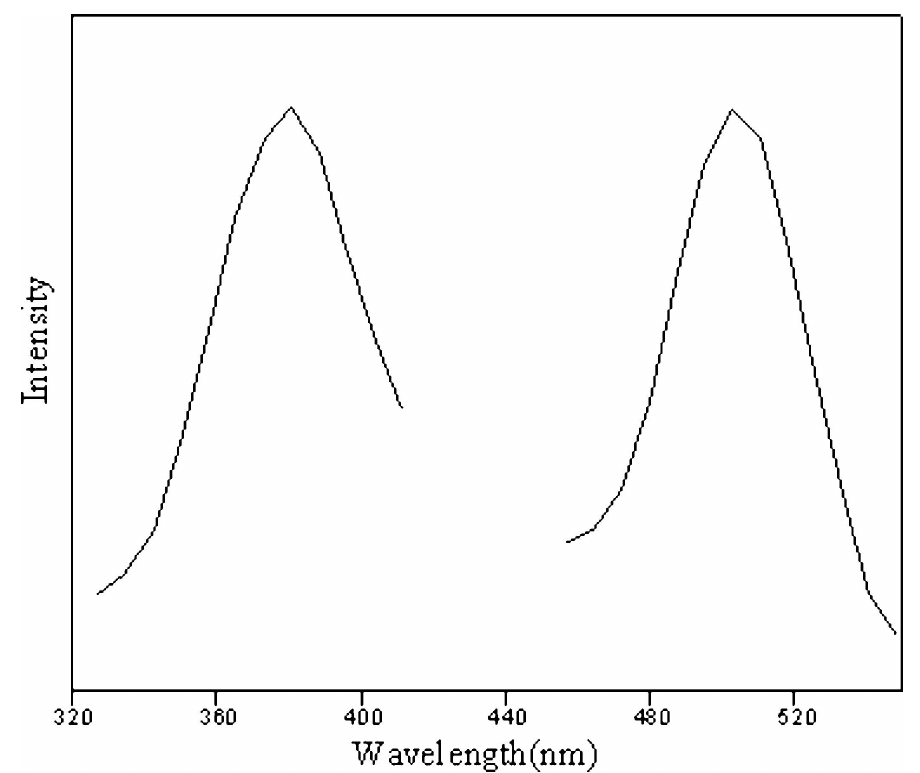
Figure 5 Solid-state emission spectra of the title complex (I) at room